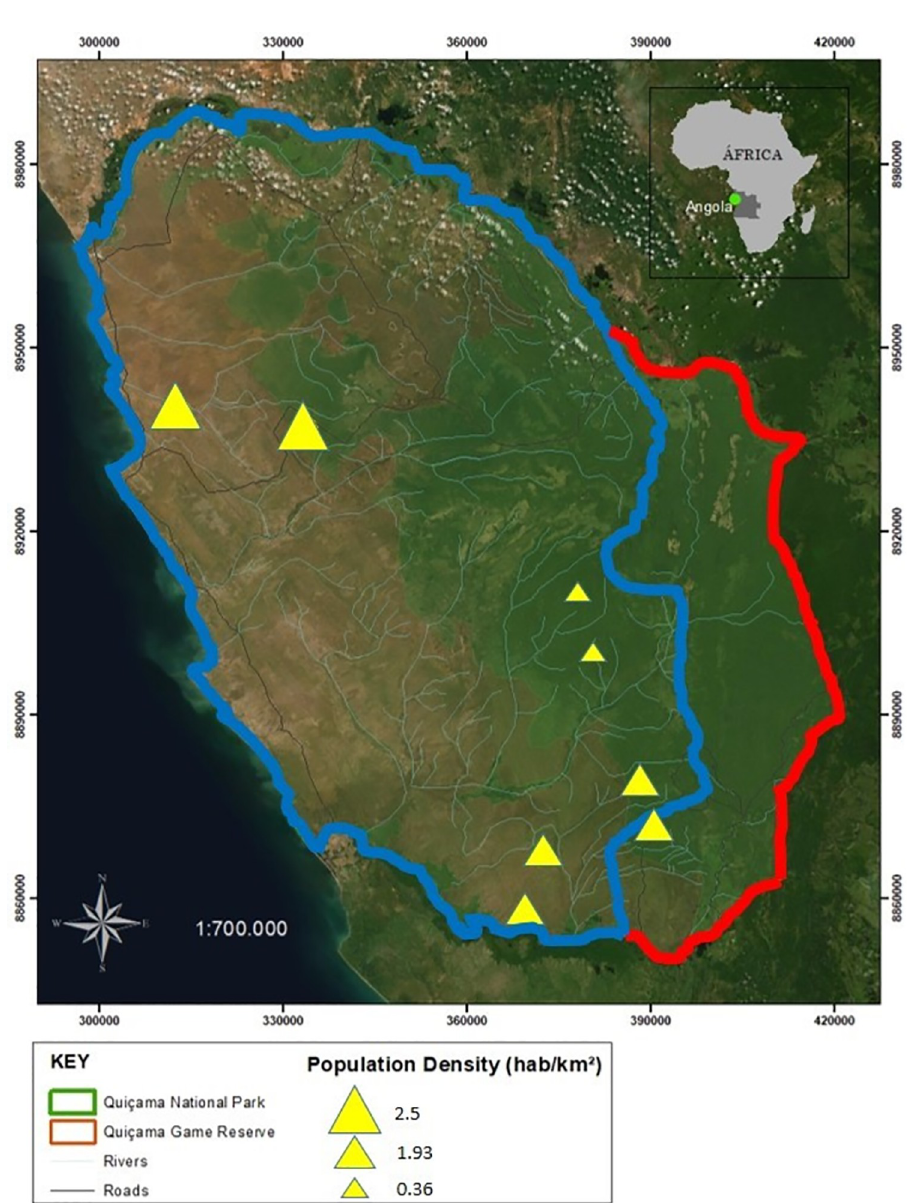
Fig 1. Location of Quic¸ama National Park (demarcated by the blue line) and Quic¸ama Game Reserve (red line) in Southwest Africa. Solid yellow triangles indicate the surveyed townships, which encompassed more than one human settlement. Triangles sizes are proportional to the population size of the townships. Green and brownish background areas represent forest and savannah environments, respectively. Map generated using ArcGIS 10.3.1; Datum: WGS84. Elaborated by Ana Caroline Imbelloni; Franciany Braga-Pereira in